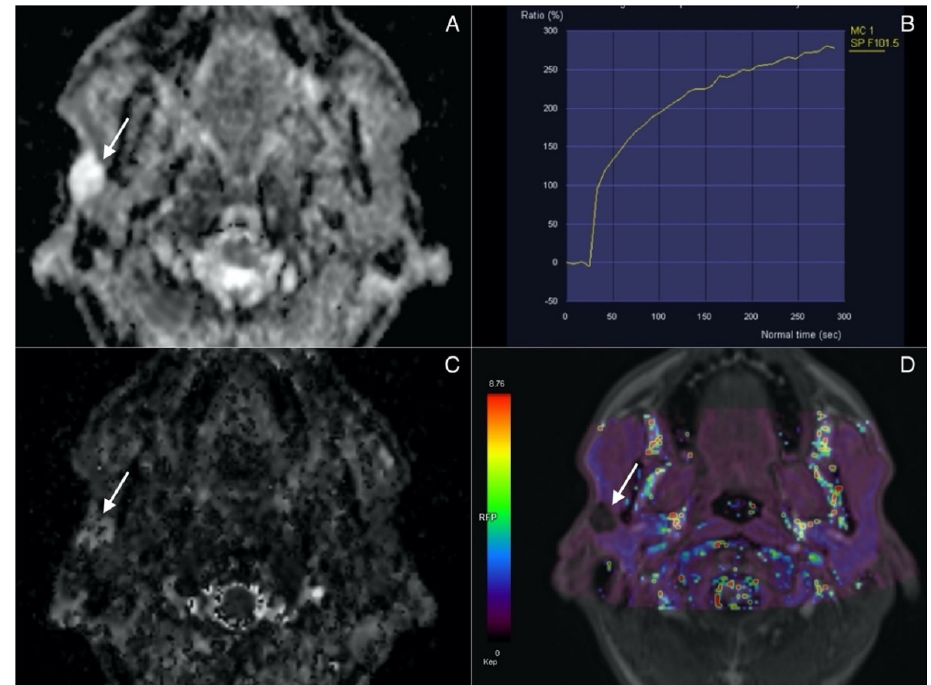
Biology 2022 , 11 , x 8 of 12 Figure 2. Pleomorphic adenoma (arrow) in superficial lobe of the right parotid. ( A ) ADC map. Lesion presents with high signal intensity correlating with lack of diffusion restriction. ( B ) Time